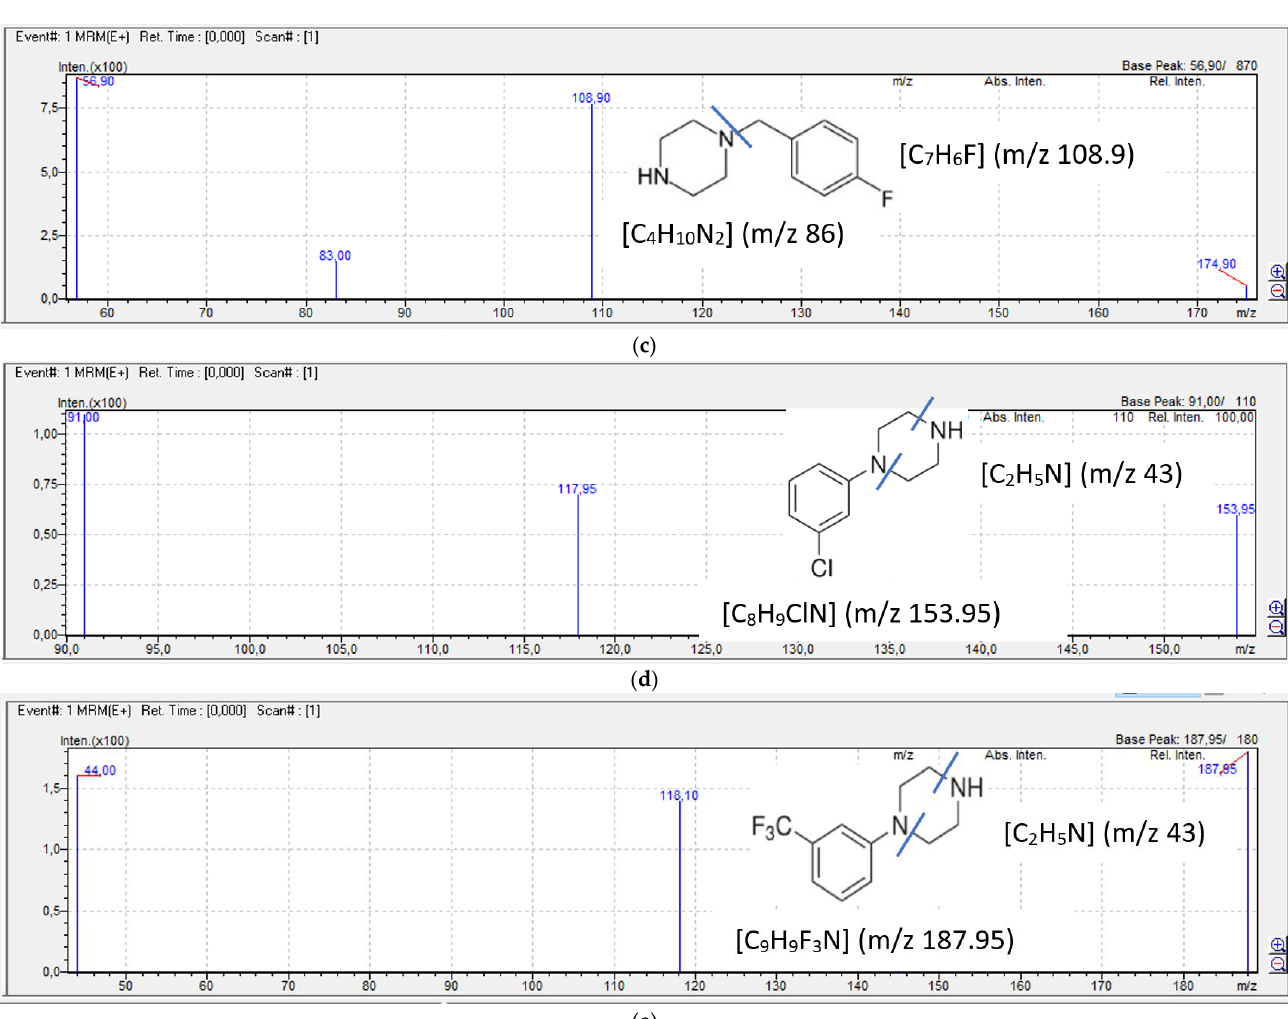
Figure 3. Mass spectra and major fragmentation patterns of piperazine designer drugs observed in mass spectrometry: ( a ) BZP, ( b ) MDBP, ( c ) pFBP, ( d ) mCPP, ( e ) TFMPP.